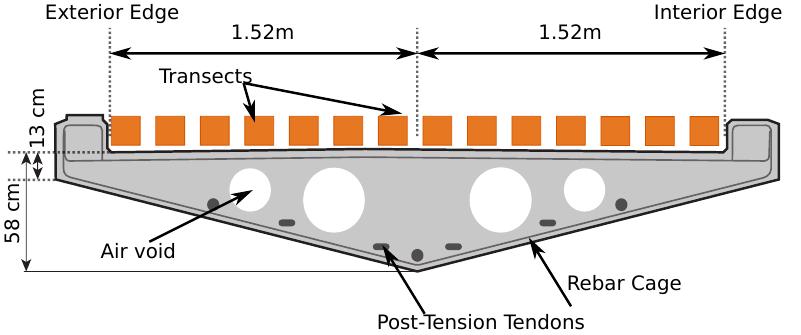
Figure 7. Southeast leg section showing location of GPR scans. Transects run longitudinally from main span down the SE and NE legs (adapted from